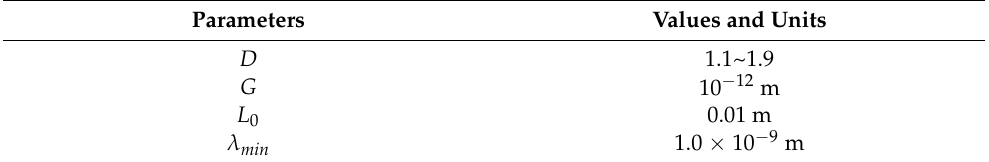
Table 1. The parameters of surface profiles.